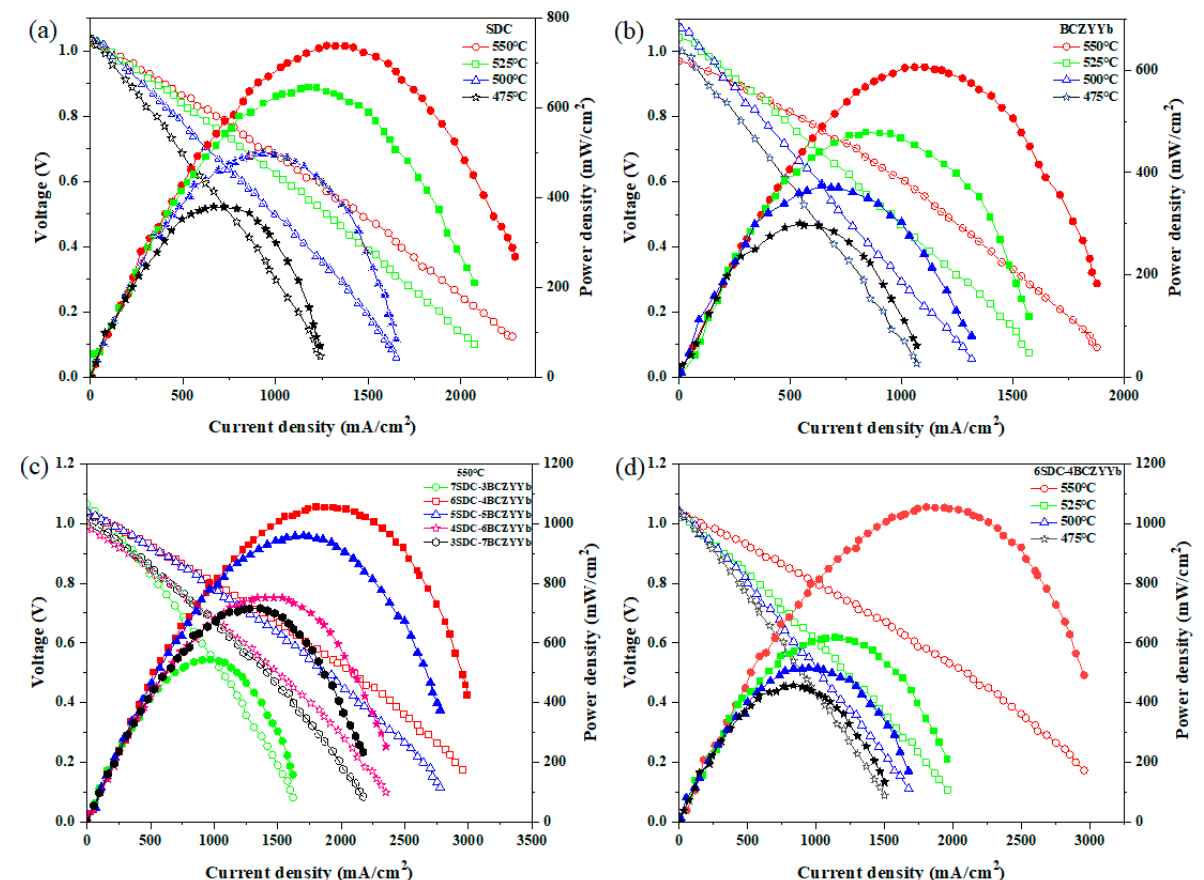
Figure 4. Typical I–V and I-P characteristic curve utilizing pure ( a ) SDC, ( b ) BCZYYb as an electro- lyte in fuel cell operated at different operating 475–550 °C. ( c ) Fuel cell performance using our pre- pared different heterostructure composites of BZCYYb-SDC as an electrolyte under 550 °C. ( d ) Elec- trochemical performance of 6SDC-4BZCYYb different operating temperatures of 475–550 °C.